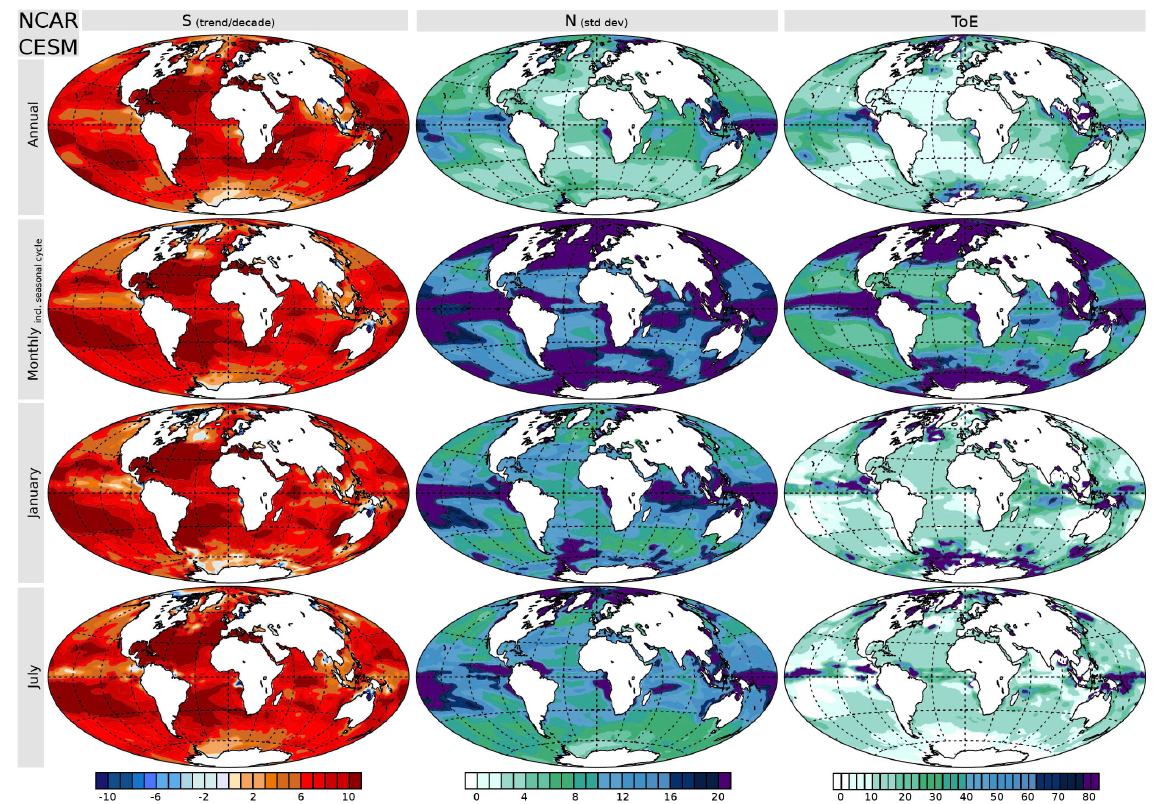
Figure 4. NCAR CESM1: Trend per decade ( S ), standard deviation ( N ) and ToE (years) of dissolved inorganic carbon (DIC; mmolm − 3 ) for the period 1975–2004. S and N are calculated on a basis of annual averages (#30, row 1), monthly averages, including full seasonal cycle (#360, row 2), January only (#30, row 3), and July only (#30, row